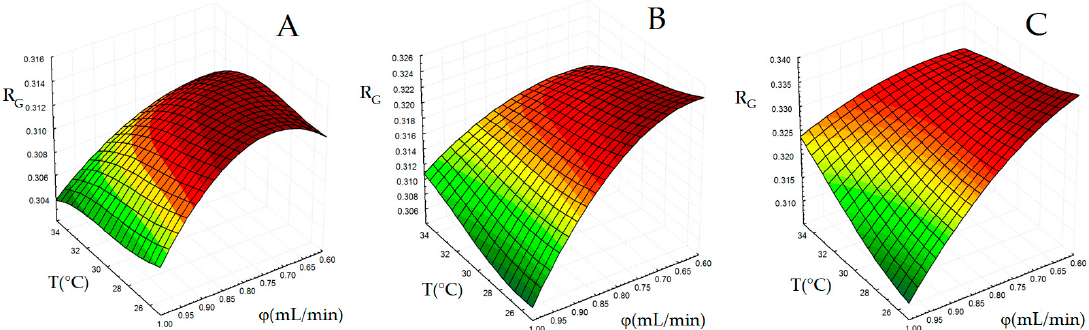
Figure 3. Plots of response surface for global resolution (R G ) as a function of column temperature (T) and eluent flow rate ( φ ), the eluent gradient duration (t g ) kept fixed at 8 ( A ), 10 ( B ) or 12 min ( C ).